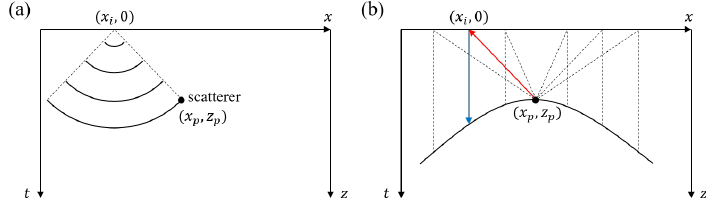
Figure 1. Formation of a hyperbola shape curve in a B-scan image. ( a ) The acoustic wave generated at the surface ( x i , 0 ) propagates into the specimen with a spherical wavefront and then spherically returns from ( x p , z p ) . ( b ) The time delays plotted with respect to the lateral scanning positions form a hyperbolic curve. The lengths of red line and blue line are